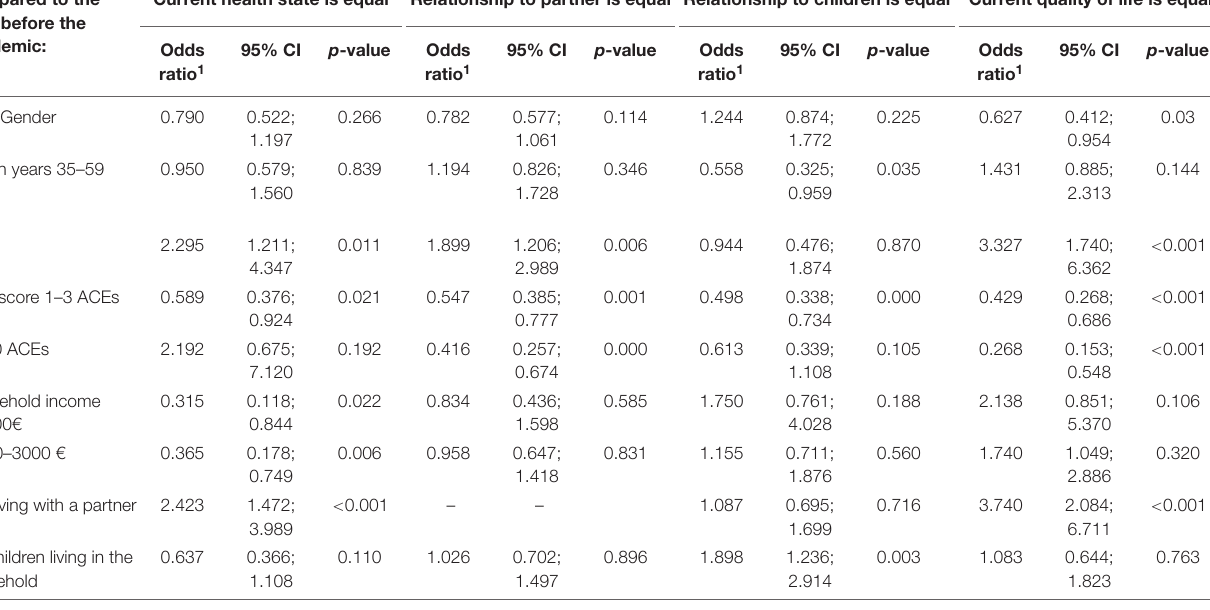
TABLE 2 | Factors associated to equally and worse rated health and intrafamilial relations compared to improvements since the beginning of the pandemic. Compared to the time before